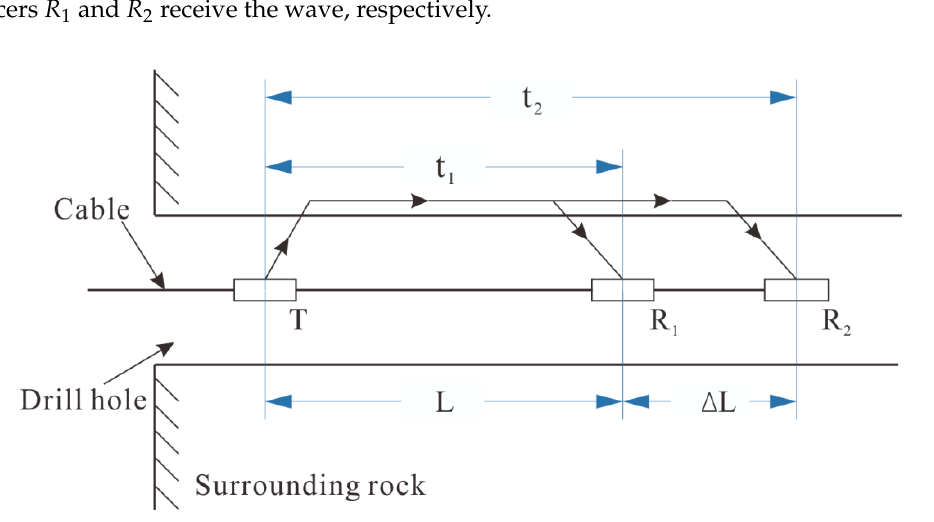
Figure 9. Operation principle of the single-emission and double-receiving measurement method.